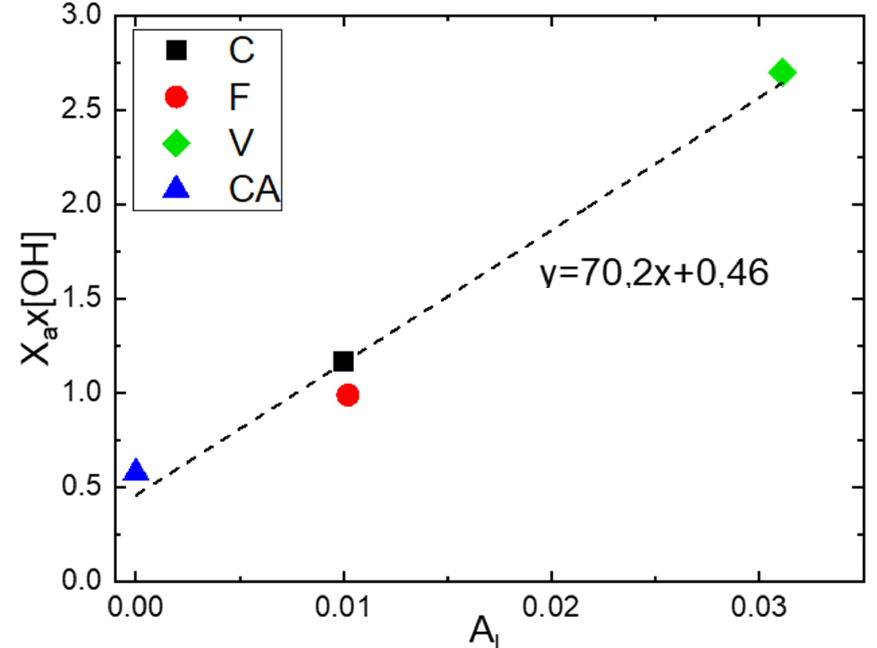
Figure 7. Evolution of the product X a × [ OH ] as a function of A L